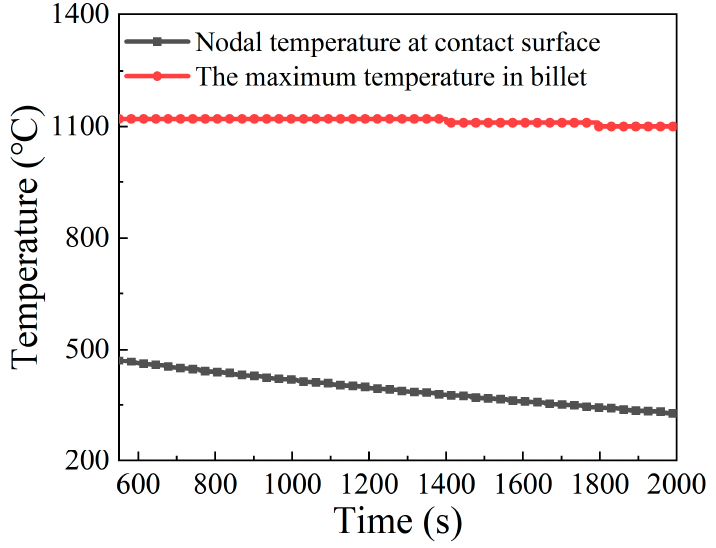
Figure 19. Evolution of the maximum temperature and the nodal temperature of contact surface along with electric upsetting time during the stable deformation stage.